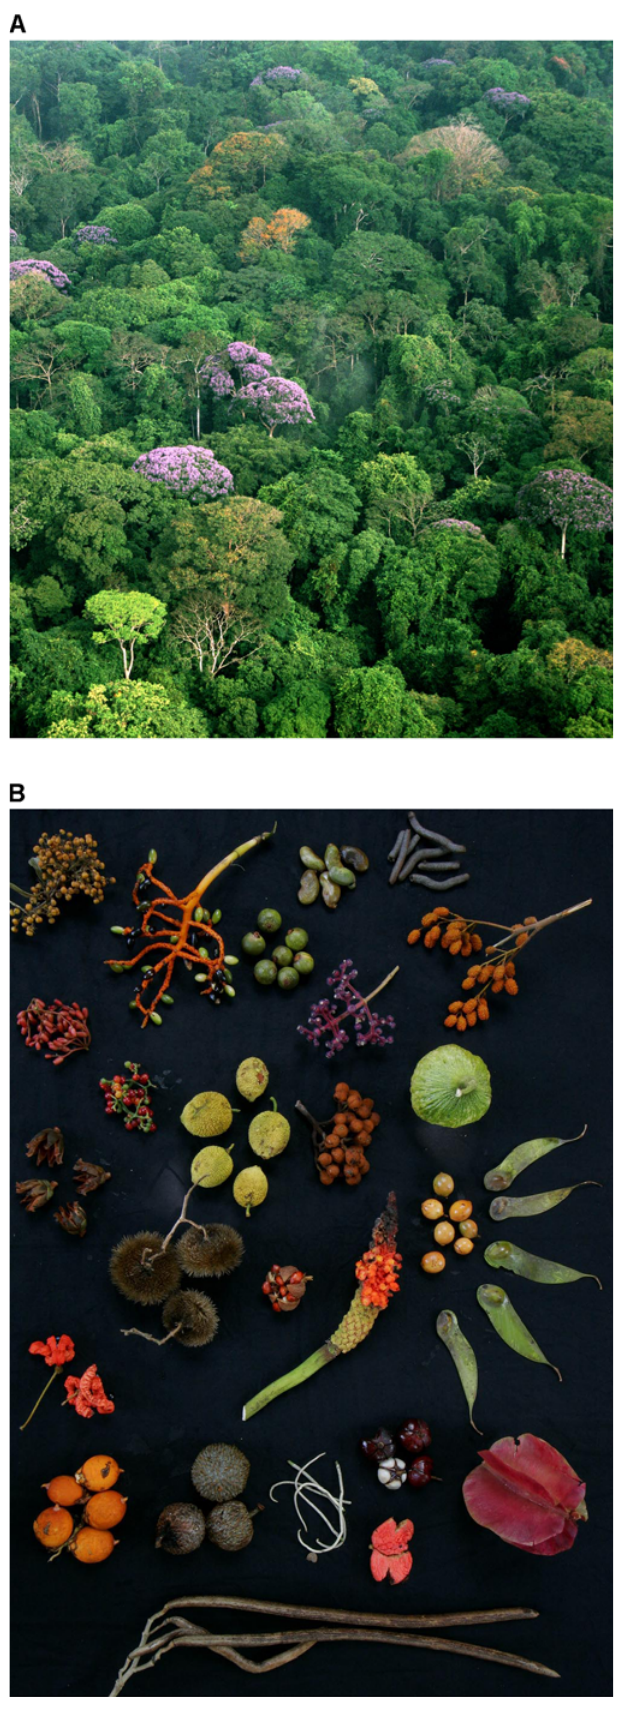
Figure 1. Conservation Efforts Hinge on Understanding the Factors Controlling Biodiversity (A) The diverse forest canopy on Barro Colorado Island, Panama, has provided ecologist Stephen Hubbell with years of data to test his controversial neutral theory of biodiversity and biogeography. (B) Despite the different fruit types and dispersal modes pictured here, Hubbell wonders how well patterns of diversity can be explained by focusing on the similarity of species rather than their differences. Photos courtesy of Christian